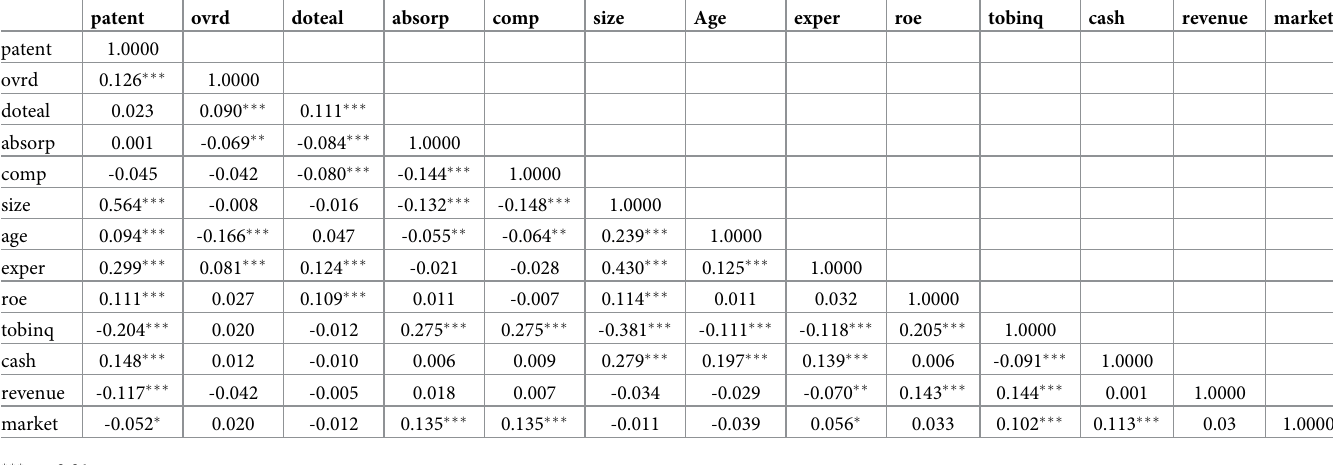
Table 2. Variable relationship description